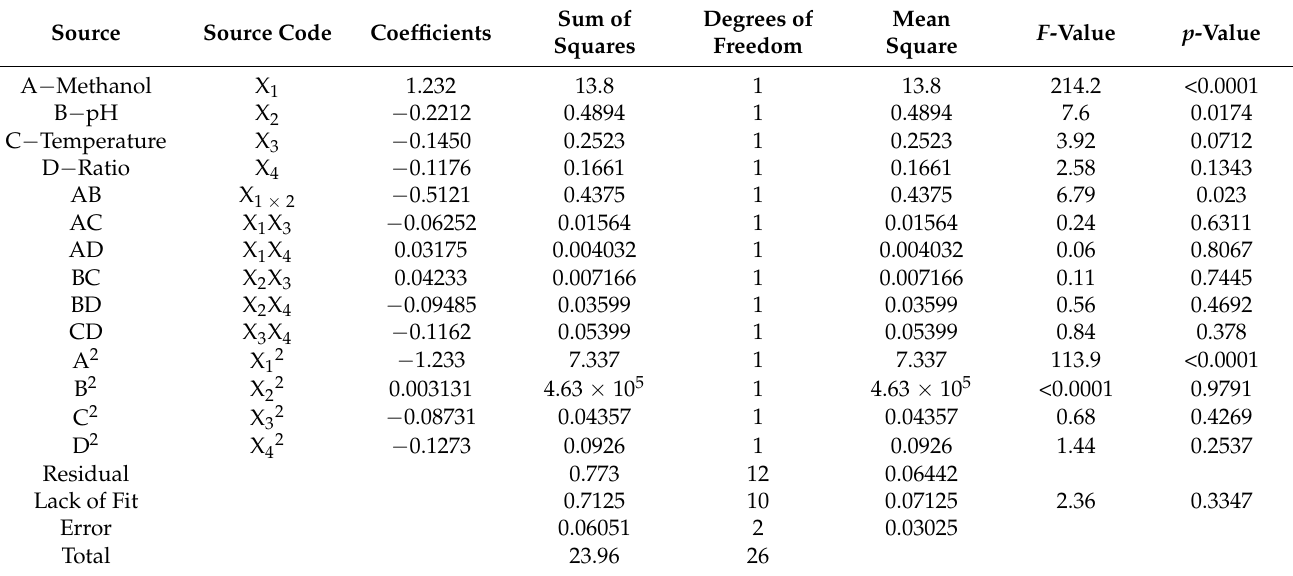
Table 3. ANOVA results for the Y TF response